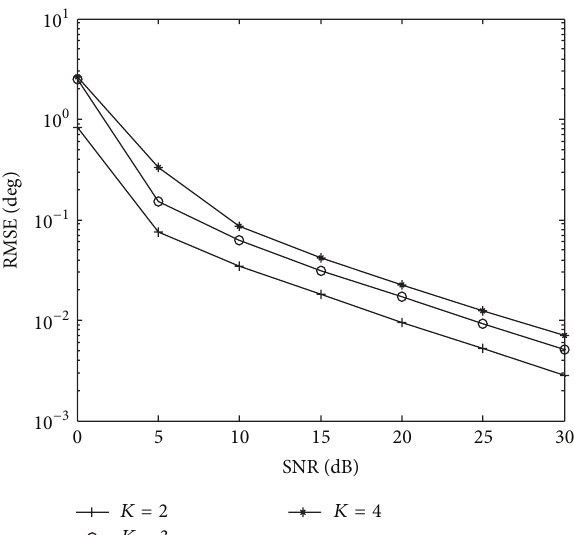
Figure 3: Angle estimation comparison performance.